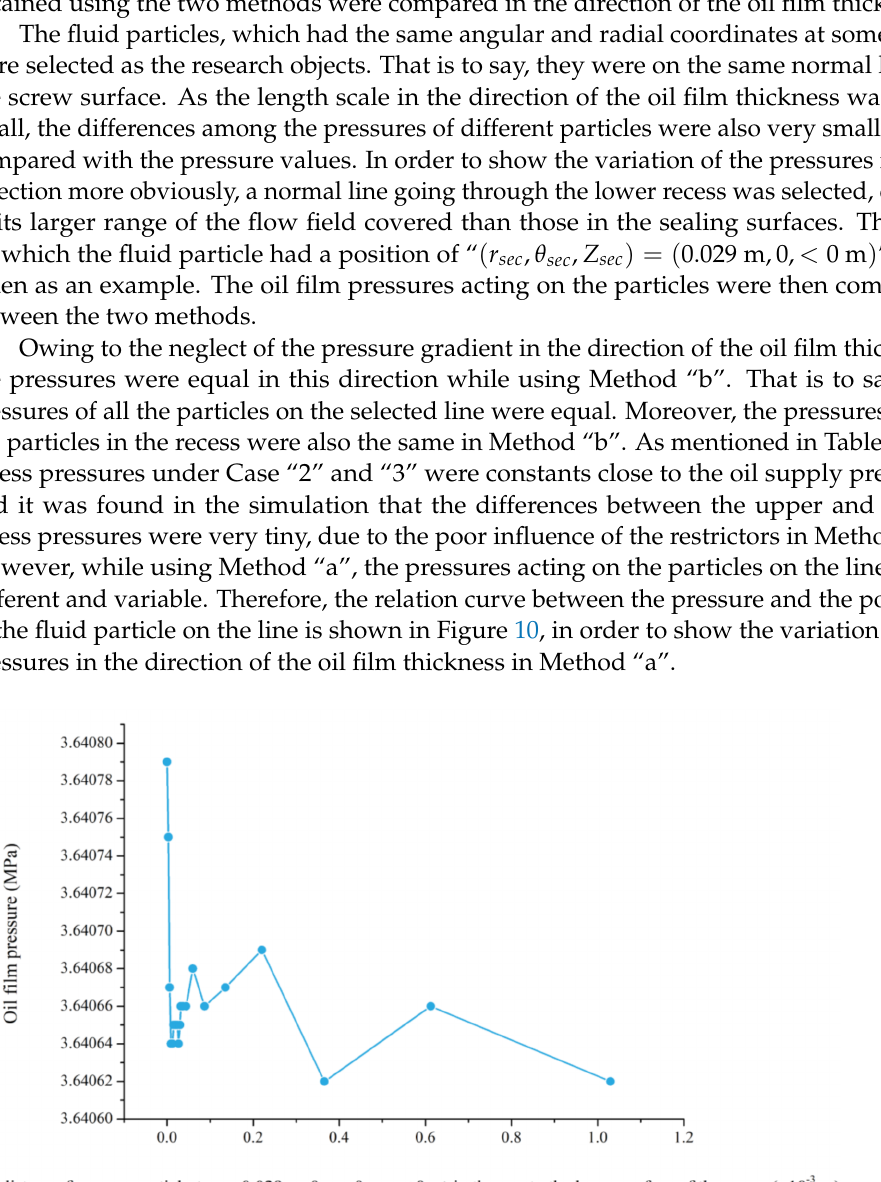
Figure 10. Variation of the pressures acting on the fluid particles in the Z sec -axis